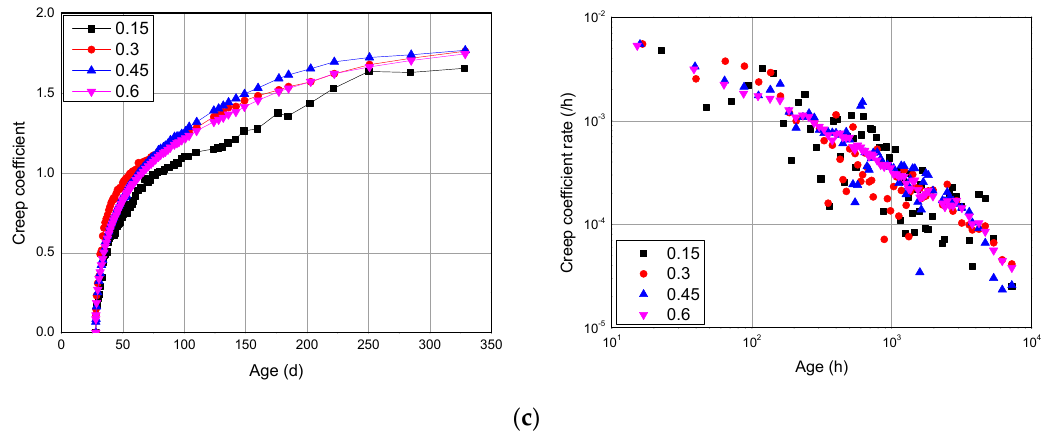
Figure 6. Effects of stress–strength ratio on the creep property of AAS concrete: ( a ) stress-dependent strain; ( b ) specific creep; ( c ) creep coefficient.